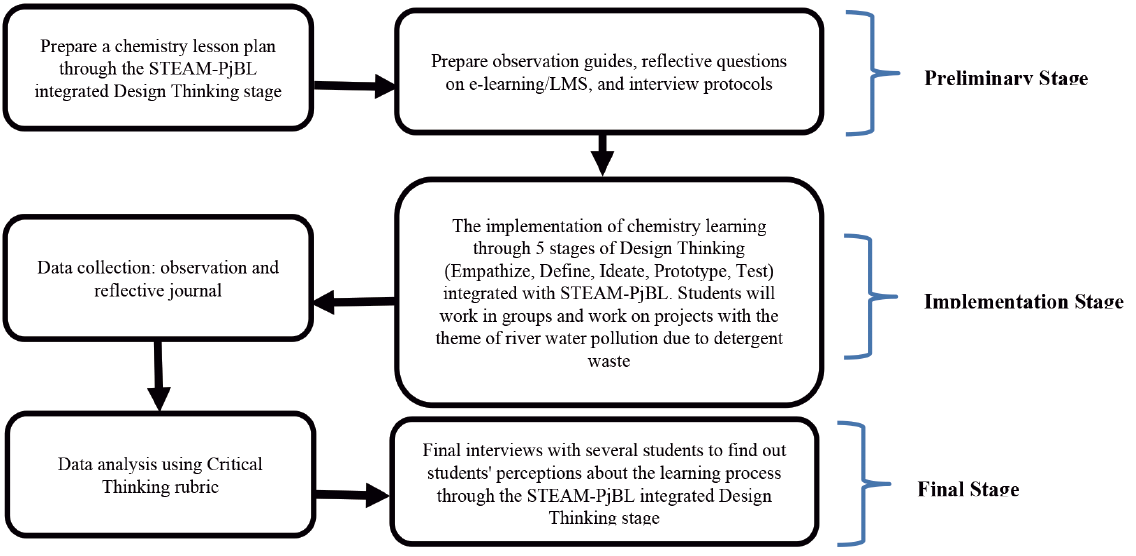
Figure 2. Research procedure